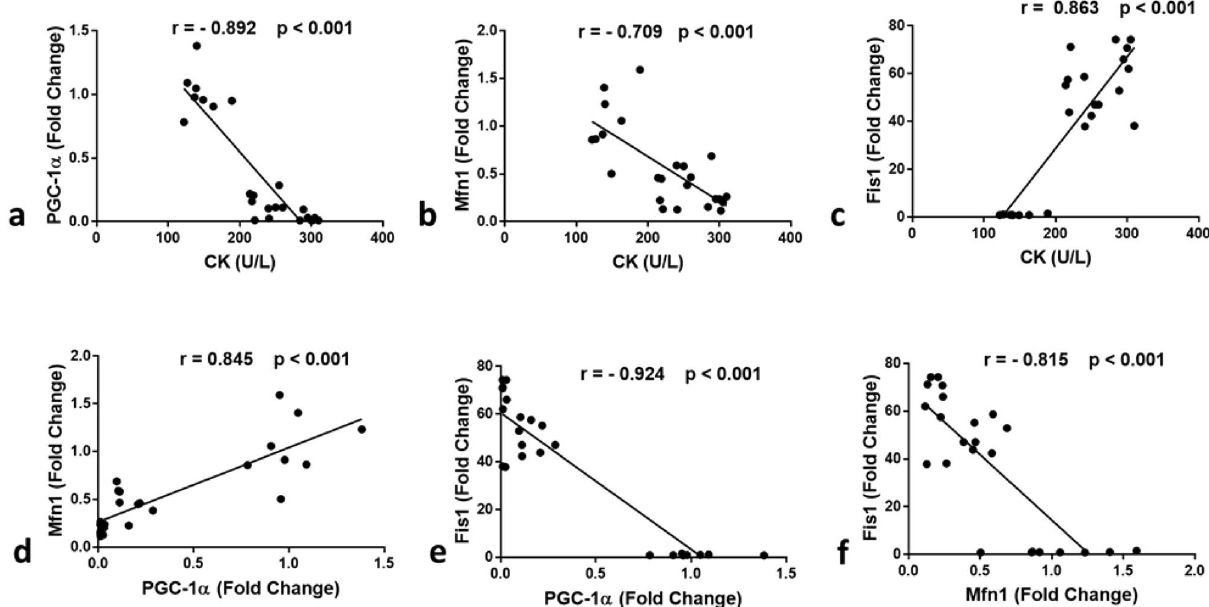
Figure 6. Correlation between ( a ) CK and PGC-1α; ( b ) CK and Mfn1; ( c ) CK and Fis1; ( d ) PGC-1α and Mfn1; ( e ) PGC-1α and Fis1; ( f ) Mfn1 and Fis1. Significant positive correlation was found between ( c ) CK and Fis1 (r = 0.863, P < 0.001), ( d ) PGC-1α and Mfn1 (r = 0.845, P < 0.001). On the other hand, significant negative correlation was found ( a ) CK and PGC-1α (r = − 0.892, P < 0.001), ( b ) CK and Mfn1 (r = − 0.709, P < 0.001), ( e ) PGC-1α and Fis1 (r = − 0.924, P < 0.001), ( f ) Mfn1 and Fis1 (r = − 0.815, P < 0.001). r: Pearson correlation factor. The Correlations are analyzed between the studied parameters in the control, Free SV, and FSM-1 groups (n =